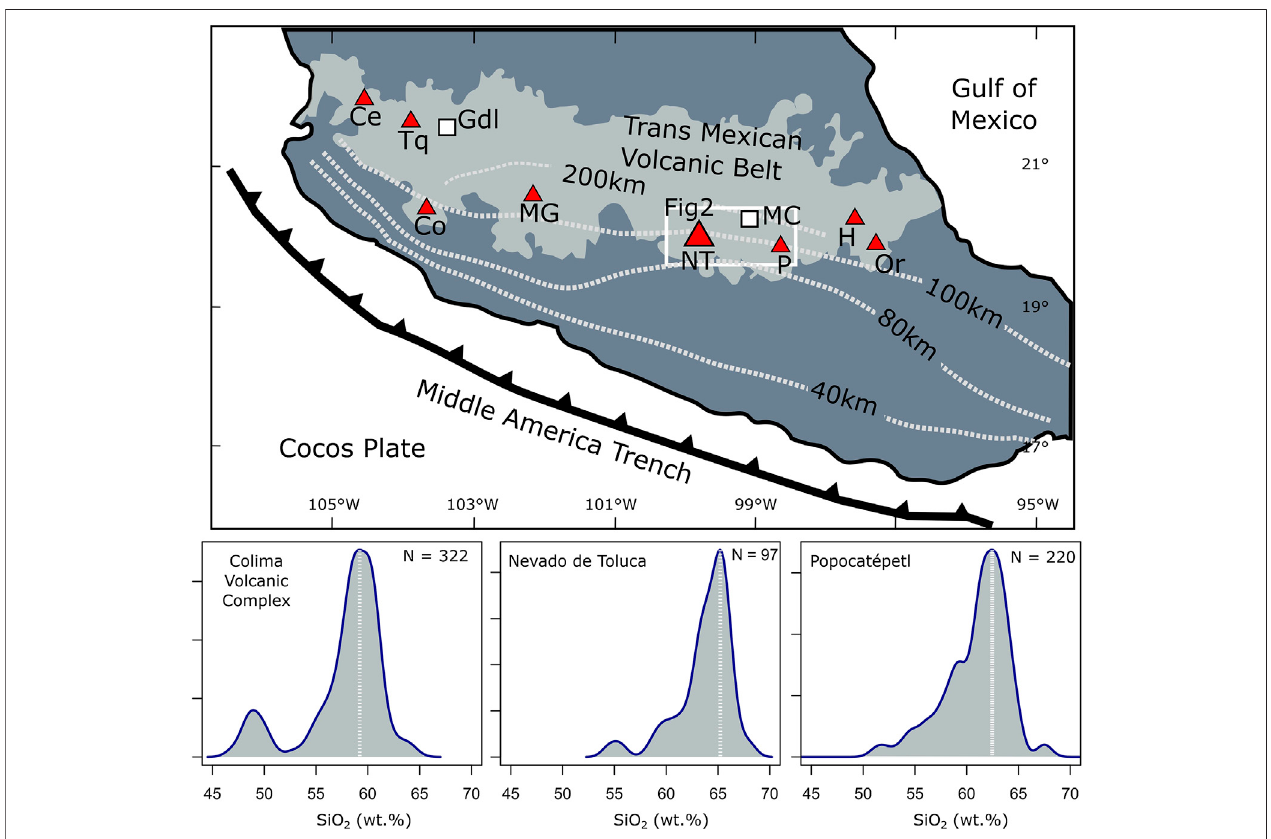
FIGURE1| LocationofNevadodeTolucavolcano(NT)andpetrologicaldiversityofstratovolcanoesintheTransMexicanVolcanicBelt.Thelightgrayshaded area marks the extent of the Neogene Trans Mexican Volcanic Belt in Central Mexico after Ferrari et al. (2012). The dashed white lines indicate the inferred depth of the subducting oceanic slab (Pardo and Suárez, 1995). Red triangles mark the location of major volcanic systems: Ceboruco (Ce), Volcán Tequila (Tq), Colima Volcanic Complex (Co), Michoacán-Guanajuato monogenetic fi eld (MG), Nevado de Toluca (NT), Popocatépetl (Po), Los Humeros Caldera (H), Pico de Orizaba (Or). For orientation, thelocations ofMexico City(MC)and Guadalajara (Gdl) areshown bywhitesquares.The threesubpanelsbelowthemap show density distributions ofbulk- rockSiO 2 (wt%)contentfortheColimaVolcaniccomplex(left,datafromGEOROC),Popocatéptlvolcano(right,datafromGEOROC),andNevadodeToluca(center,this study). Care was taken to exclude oversampling of prominent eruptions. N indicates the number of analysis.